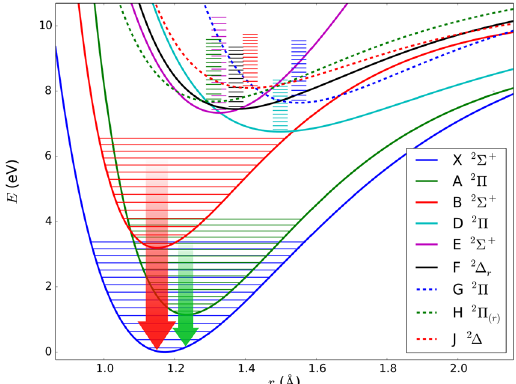
Figure 4. Potential energy surfaces for ∙CN radical in several electronic excited states. The electronic ro- vibrational transitions observed using infrared emission time resolved spectroscopy of electric discharge and optical emission spectroscopy of laser plasma are marked in green and red